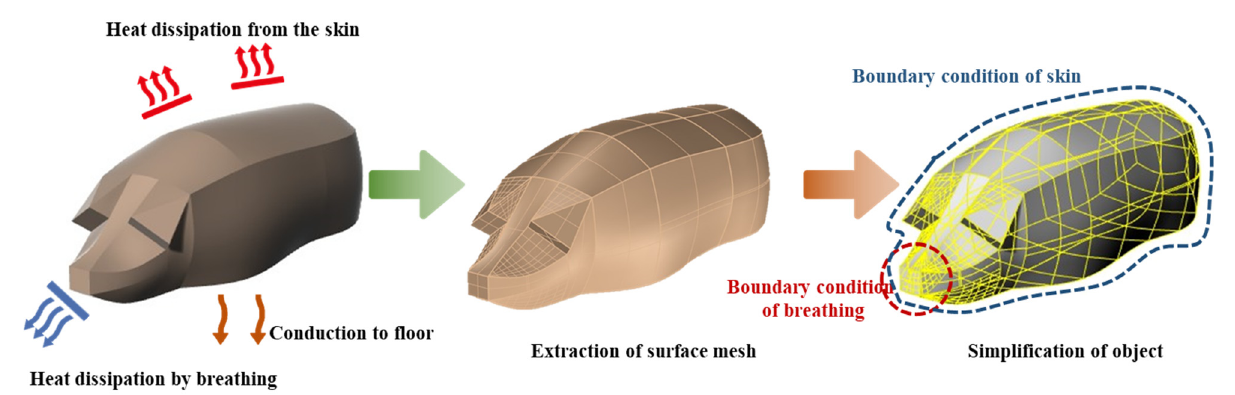
Figure 7. Heat generation rate of body surface of pig and breathing. Moisture and ammonia generation rates from the manure were simulated to generate and diffuse from the pit space located at the bottom of the piglet house. The moisture generation rate was applied in consideration of the ratio between the size of the pig house used in the previous study and the size of the pig house applied in this study [28]. In addition, the ammonia generation rate was converted to the ammonia concentration measured in the experimental piglet house and applied in the CFD model. The moisture and ammonia gas should pass through the pit slot on the bottom to diffuse from the pit space. The airflow can be resisted by the structure of the pit slot. Therefore, the floor of